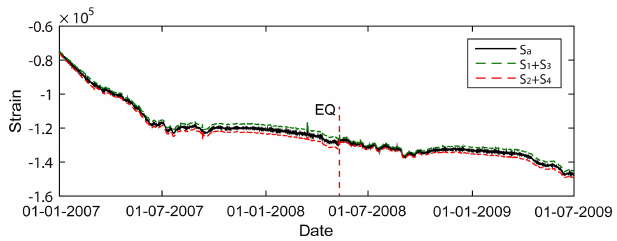
Figure 2. Self-consistency of the borehole strain at Guza from 1 January 2007 to 30 June